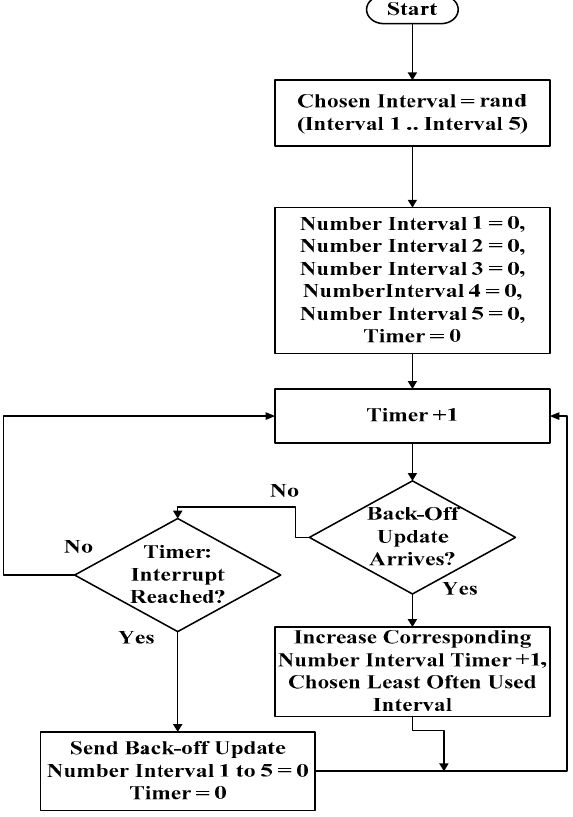
Figure 4. Back-Off Time Optimization based on the Ant Colony Optimization Algorithm (Unused Intervals).